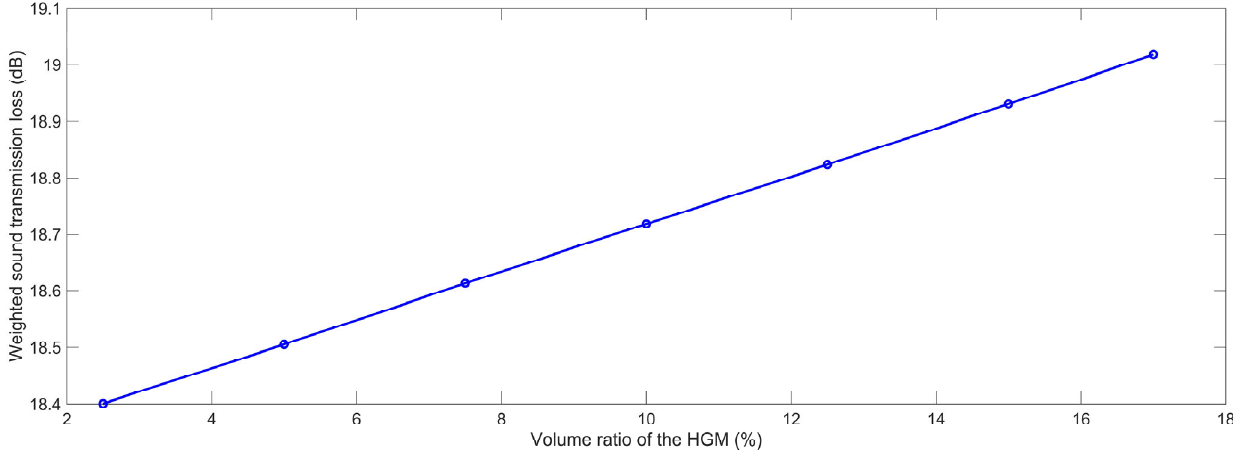
Figure 9. The weighted STL of composite rubber reinforced with HGM for the various volume ratio of the HGM.